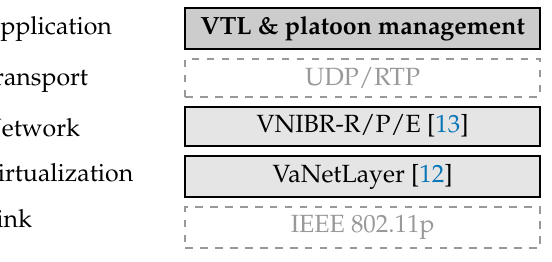
Figure 1. The stack of protocols of our approach.